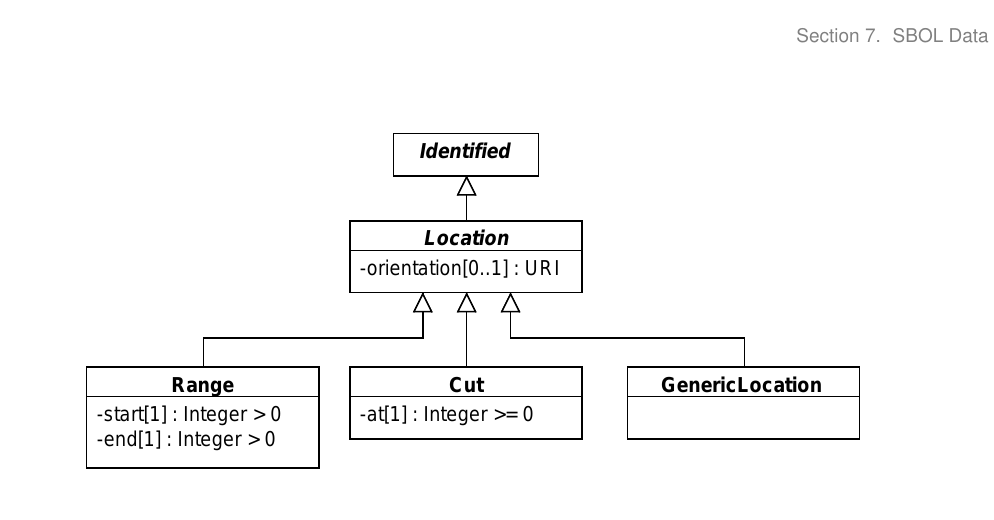
Figure 12: Diagram of the Location class and its associated properties.